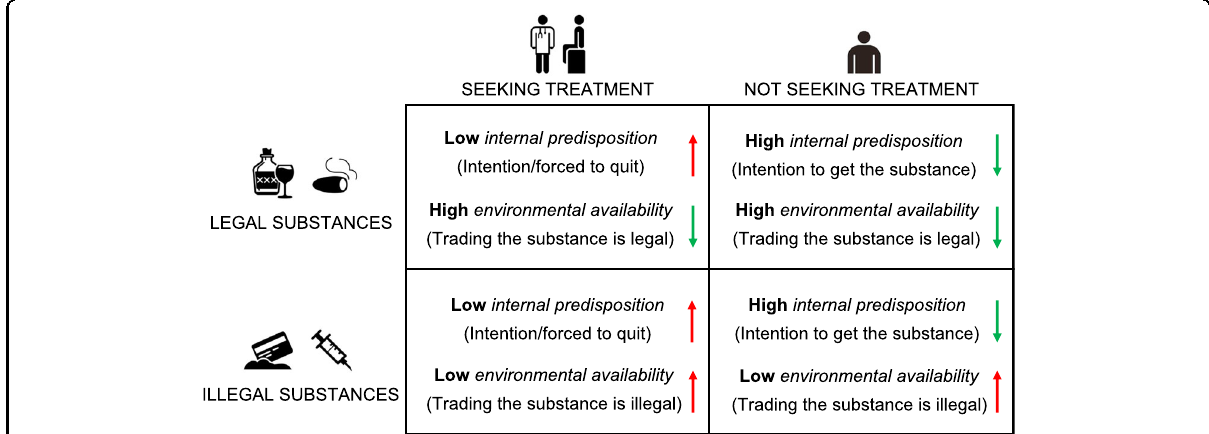
Fig. 4 Internal and environmental determinants in drug-cue reactivity. A simpli fi ed model of the interaction between class of substances and treatment status in the PFC. More frequent activity in regions involved in inter-temporal decision making and reward evaluation may re fl ect the incongruency between determinants that signal shorter delay/immediate reward (downward green arrows) vs. longer delay/absence of reward (upward red arrows): when these contingencies signal con fl icting information about the potential time frame of the reward (represented by the arrows pointing in different directions), additional decision making, and reward evaluation processes may be required to form an expectation about the delay of drug consumption. The interaction effect observed here may be in part mediated by the different drug availability implied by the type of treatment usually considered for legal (outpatient — getting the substance soon is still possible) vs. illegal (inpatient — getting the substance soon is less likely) substance